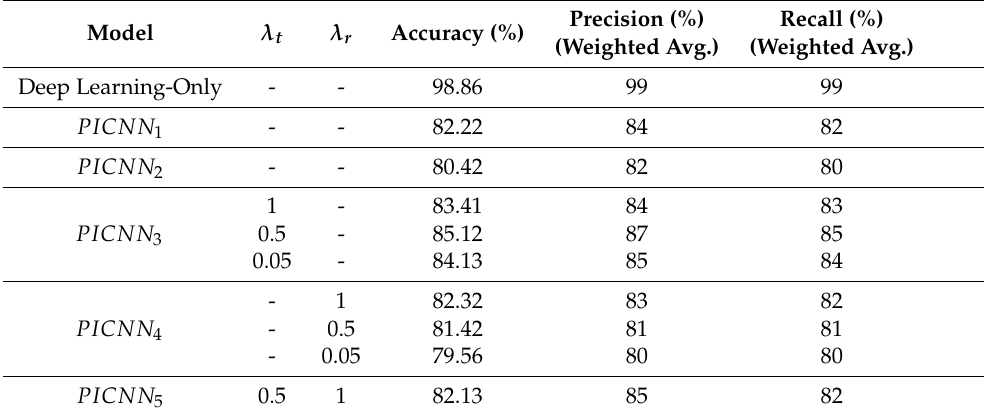
Table 2. Performance metrics for the baseline deep learning-only model and each version of the physics-informed model when tested on the training data set.